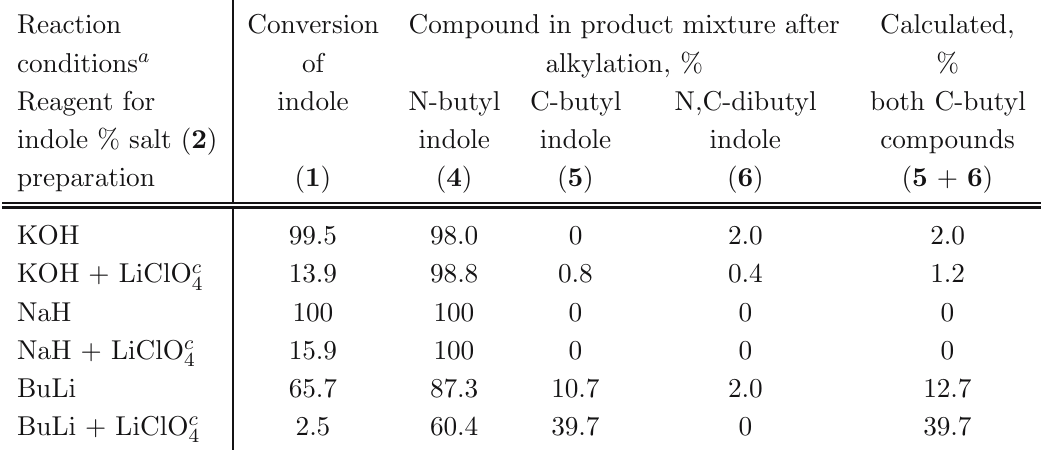
a in the reaction of indole sodium salt with 1-bromobutane in [mmim] [OTs]; b see footnotes to Table 1; c 5 mmol/LiClO 4 1 mmol